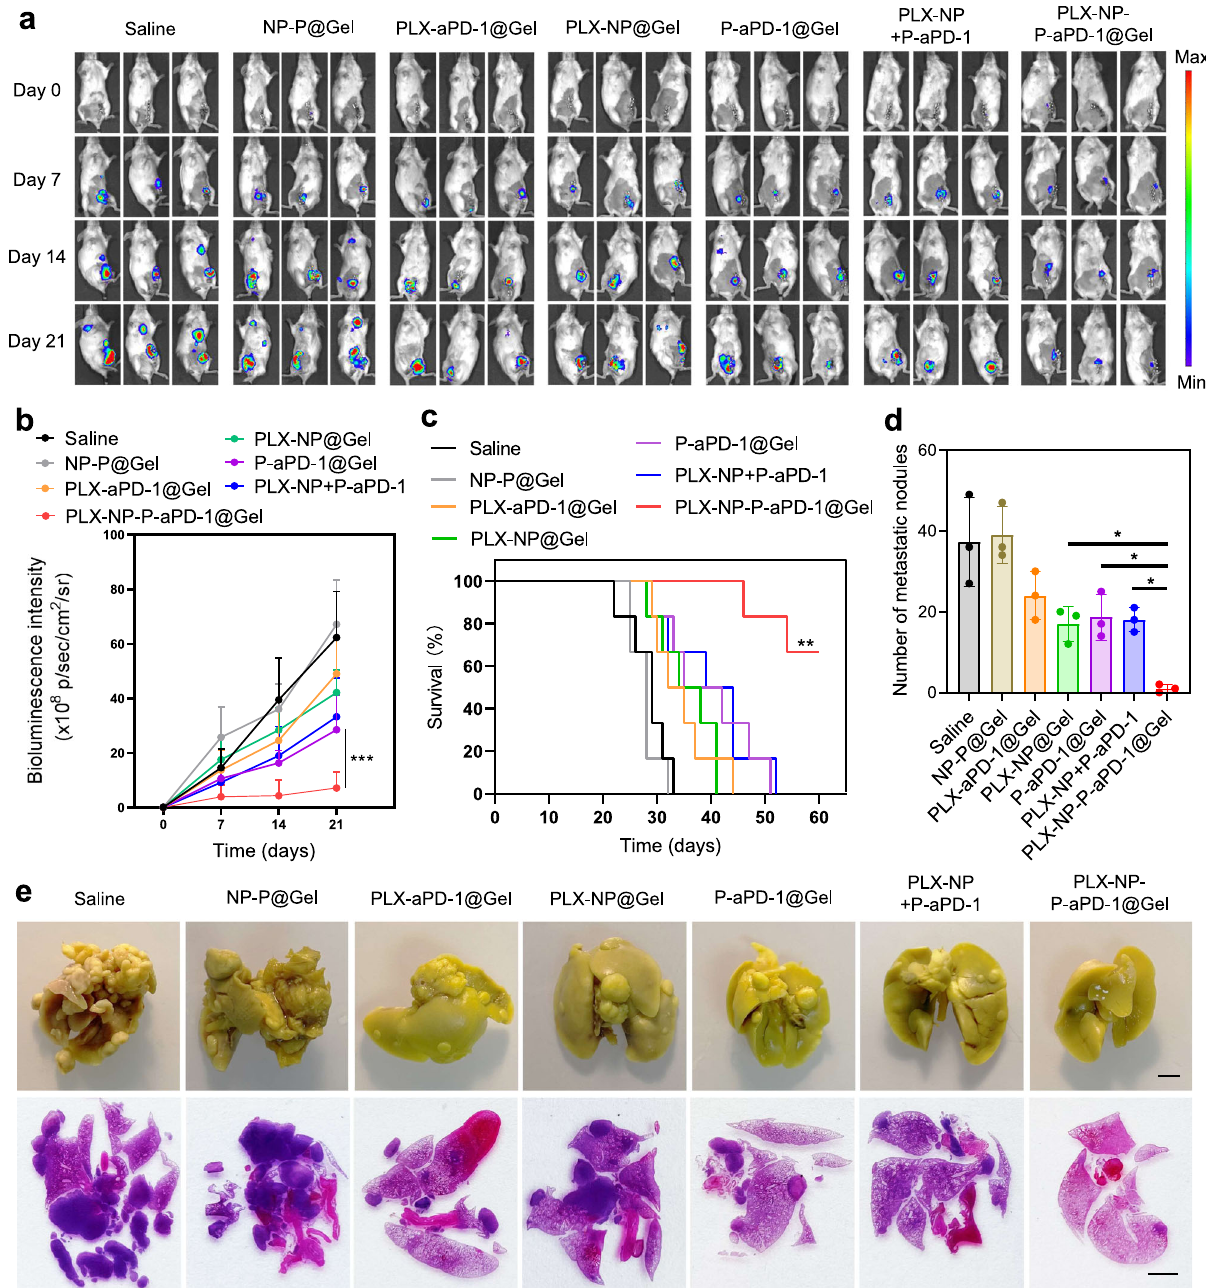
Fig. 5 Evaluation of in vivo treatment ef fi cacy of PLX-NP-P-aPD-1@Gel in metastatic 4T1 breast tumor recurrence model. a Representative bioluminescence images of 4T1 tumor-bearing mice following different treatments on day 0, day 7, day 14, day 21 ( n = 6 mice). Saline; NP-P@Gel, blank nanoparticles and unmodi fi ed platelets co-loaded hydrogel; PLX-aPD-1@Gel, free PLX and aPD-1 co-loaded hydrogel; PLX-NP@Gel, PLX-NP loaded hydrogel; P-aPD-1@Gel, P-aPD-1 loaded hydrogel; PLX-NP + P-aPD-1, free PLX-NP and P-aPD-1; PLX-NP-P-aPD-1@Gel, PLX-NP and P-aPD-1 co-loaded hydrogel. The dose of PLX and aPD-1 was 5 mg/kg and 0.1 mg/kg, respectively. b Region-of-interest analysis of bioluminescence intensity of the tumors among different treatment groups (PLX-NP-P-aPD-1@Gel vs. PLX-NP + P-aPD-1: *** P < 0.0001). Data are presented as mean ± s.d. ( n = 6 mice) and analyzed with two-way ANOVA followed by Tukey ’ s multiple comparisons test. c Survival curves of the mice treated with different treatment groups ( n = 6 mice). Data were analyzed with Log-rank (Mantel-Cox) test, PLX-NP-P-aPD-1@Gel vs. PLX-NP + P-aPD-1: ** P = 0.0018. d Quantitative analysis of the number of metastatic nodules on the surface of the lungs on day 21 (PLX-NP-P-aPD-1@Gel vs. PLX-NP@Gel: * P = 0.0313; P LX-NP-P-aPD-1@Gel vs. P-aPD- 1@Gel: * P = 0.0168; PLX-NP-P-aPD-1@Gel vs. PLX-NP + P-aPD-1: * P = 0.0215). Data are presented as mean ± s.d. ( n = 3 biologically independent samples) and analyzed with one-way ANOVA followed by Dunnett ’ s multiple comparison test. e Representative images of the lungs after fi xation in bouin ’ s solution and H&E staining after different treatments on day 21 ( n = 3 biological independent samples, scale bar = 2 mm). Source data are provided as a Source Data fi le.